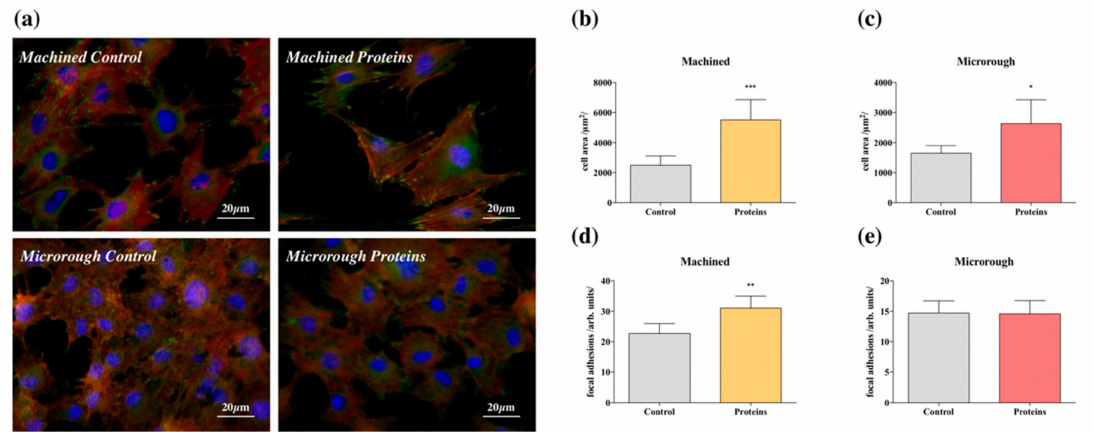
Figure 3. Fluorescence microscopy: ( a ) Representative immunofluorescence images showing MC3T3-E1 cells on machined and microrough titanium surfaces pre-conditioned or not with serum proteins, stained for actin (red), vinculin (green), and cell nuclei (blue) 24 h after seeding; ( b ) analysis of cell area of MC3T3-E1 cultures seeded on machined titanium surfaces. t -test: *** = p < 0.001; ( c ) analysis of cell area for MC3T3-E1 cultures seeded on microrough titanium surfaces. t -test: * = p < 0.05; ( d ) analysis of focal adhesions distribution along MC3T3-E1 cells seeded on machined titanium surfaces. t -test: ** = p < 0.01; ( e ) analysis of focal adhesions distribution along MC3T3-E1 cells seeded on microrough titanium surfaces. t -test: p >